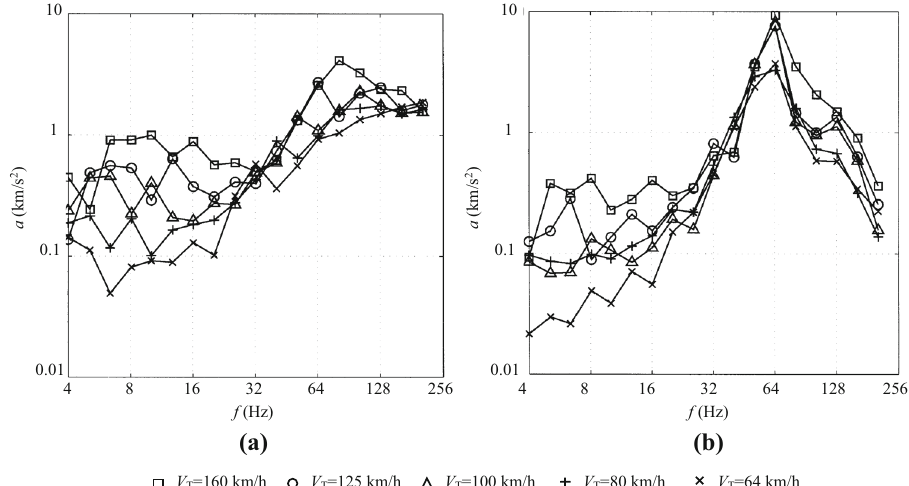
Fig. 6 Measured wheelset accelerations for different train speeds: a at a ballast track and b at a slab